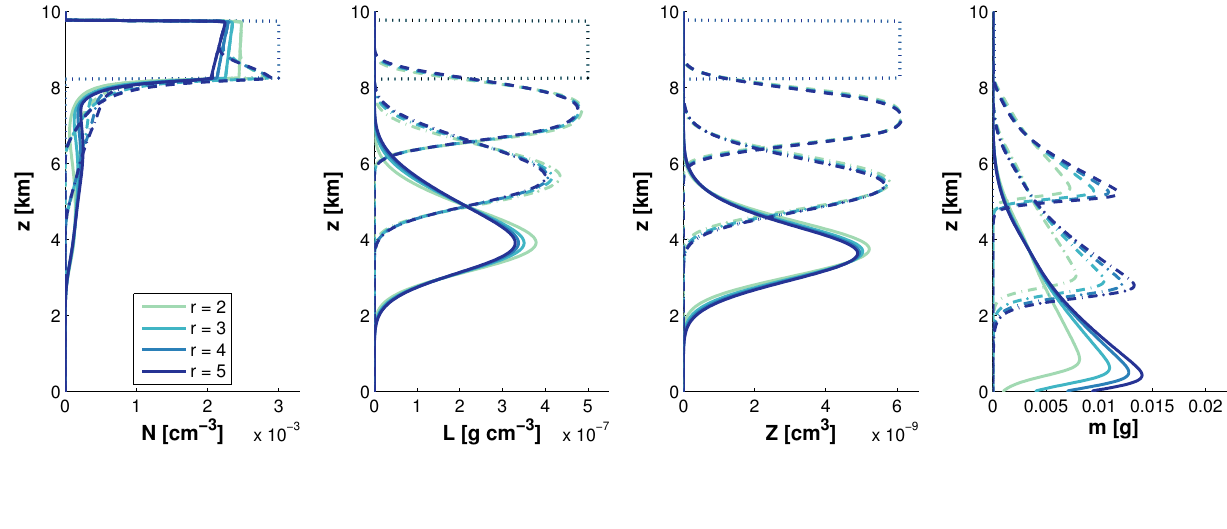
Figure A2. Profiles of N , L , Z and m using a diagnostic relationship for q ; Equation